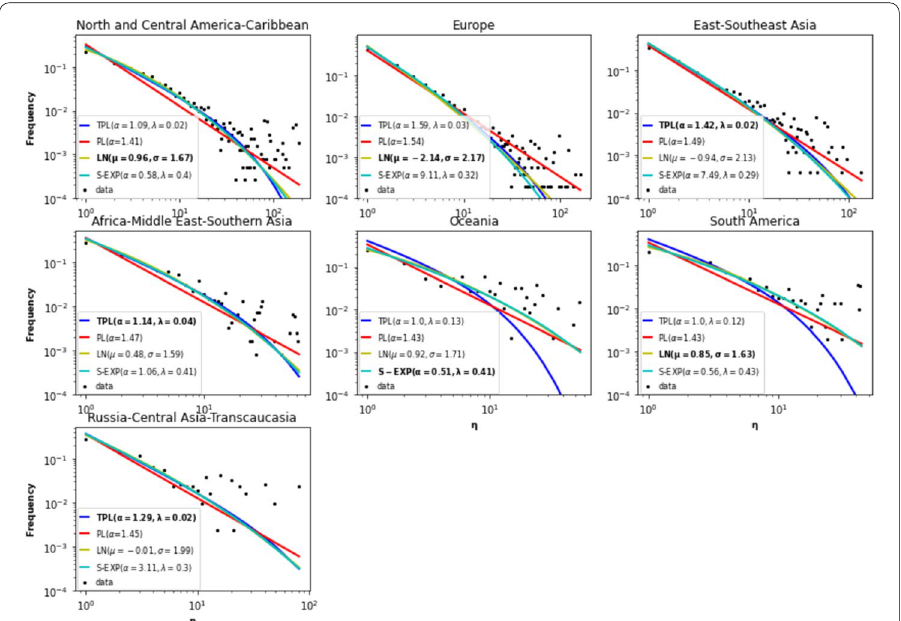
Fig. 8 Degree-degree distance distributions of the components. Empirical distribution ( dot ), estimates ( line ). The distributions under test are: power law, truncated power law, log-normal and stretched exponential. The values in bold are the parameters of the best fit according to the Kolmogorov-Smirnov test